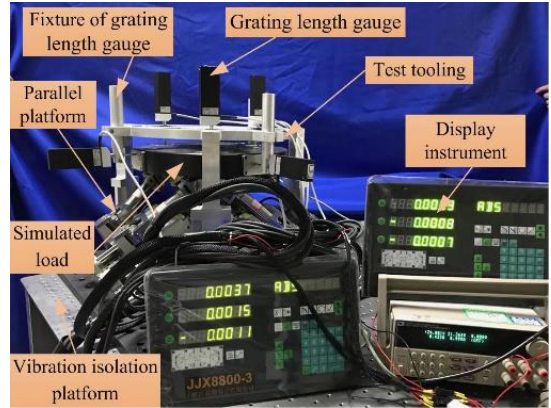
Figure 21. Test system configuration.